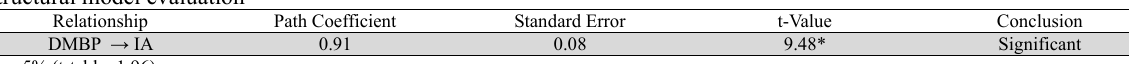
Structural model evaluation